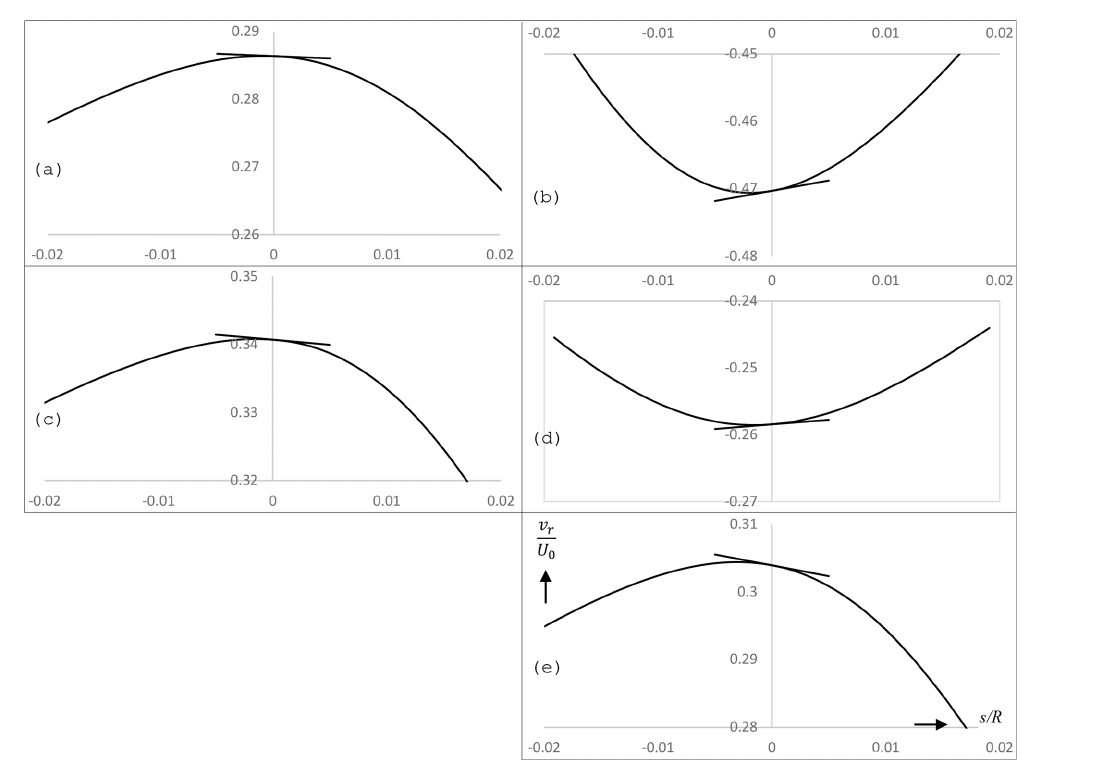
Figure 8. Curved lines: the radial velocity along the streamline passing the disc at r/R = 0 . 97; straight lines: the tangent of the distribution v s,d ( r ) /U 0 at r/R = 0 . 97, plotted through the s = 0 position at the curved